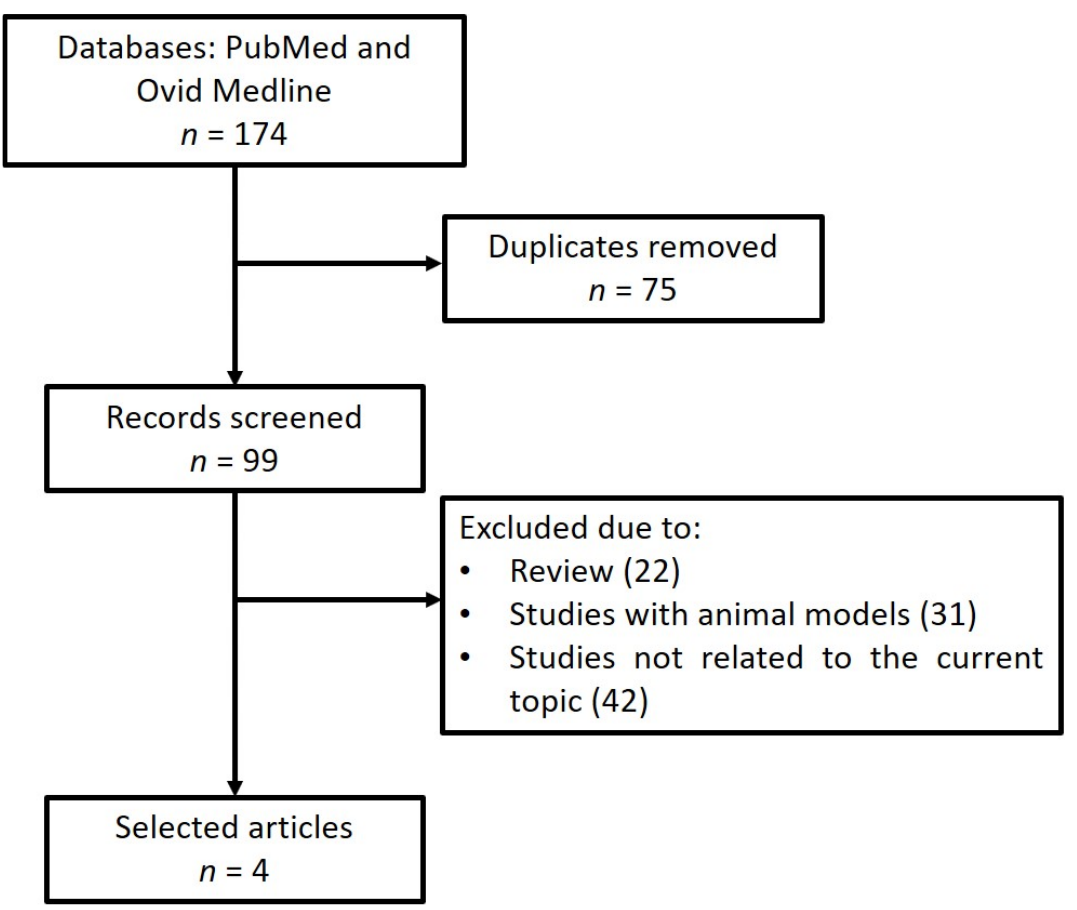
Figure 2. PRISMA flow diagram of study selection for 22q11.2 deletion syndrome and miRNA dysregulation. Table 2. Selected papers about 22q11.2 deletion syndrome and alteration of microRNA. Experimental Model